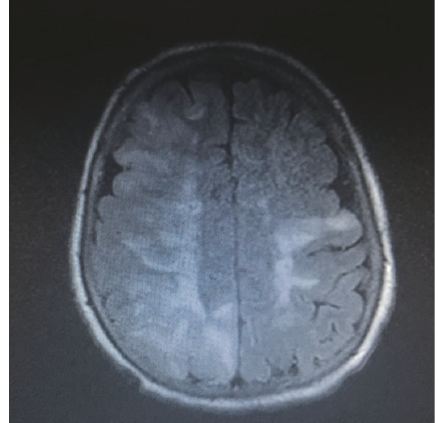
Figure 2: Initial MRI brain (FLAIR) showing bilateral frontal hyperintense white matter lesions, right > left.